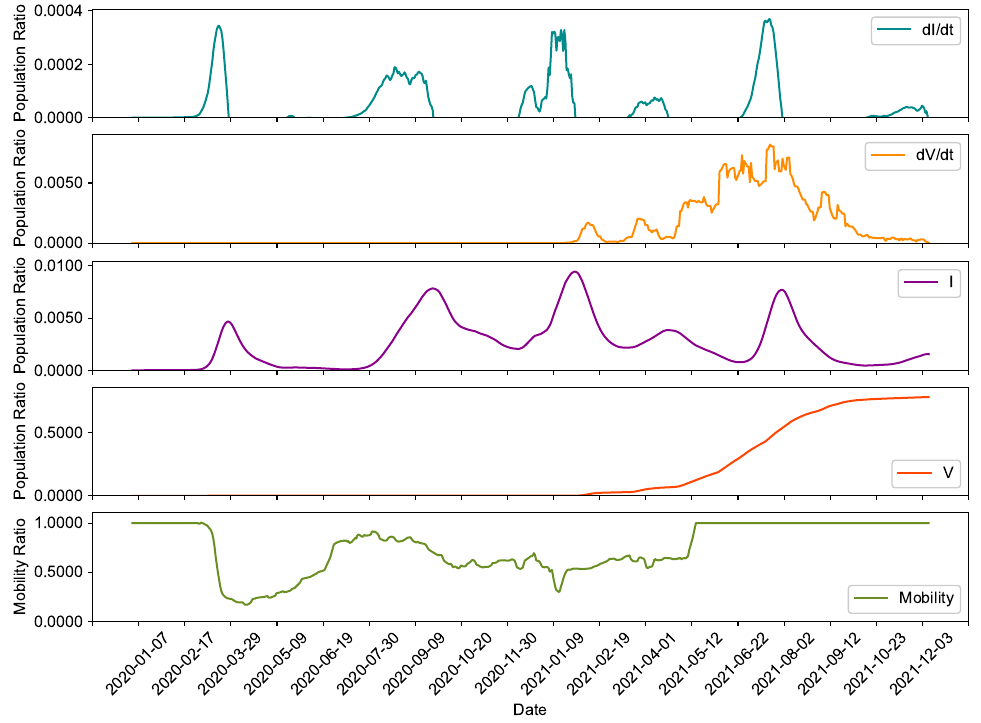
Figure 1. Input variables used for the LSTM network for Madrid. Figure 2 shows the values of dR / dt used to train and test the LSTM network with data for the Community of Madrid and the output value of the network after training.